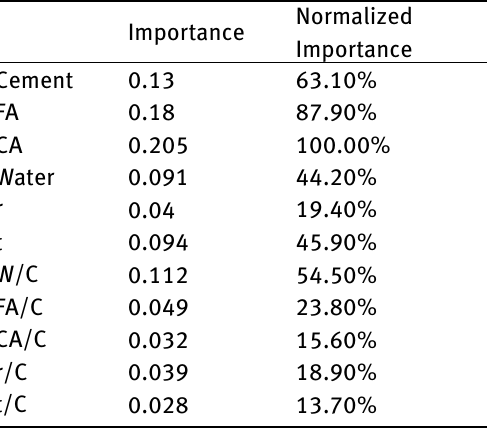
Equation of the model (Compressive Strength Model (MPa)): Y Model (N/mm 2 ) = 2.738678+0.904492*Y Lab (= Yp-N/mm 2 ) From standardized coefficients of compressive strength of tabular results of Table 12, the graphical results are plotted in Figure